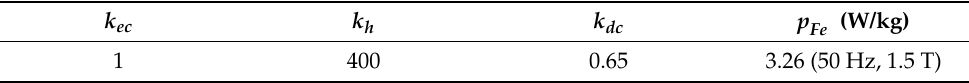
Table 5. Coefficients for the calculation of core